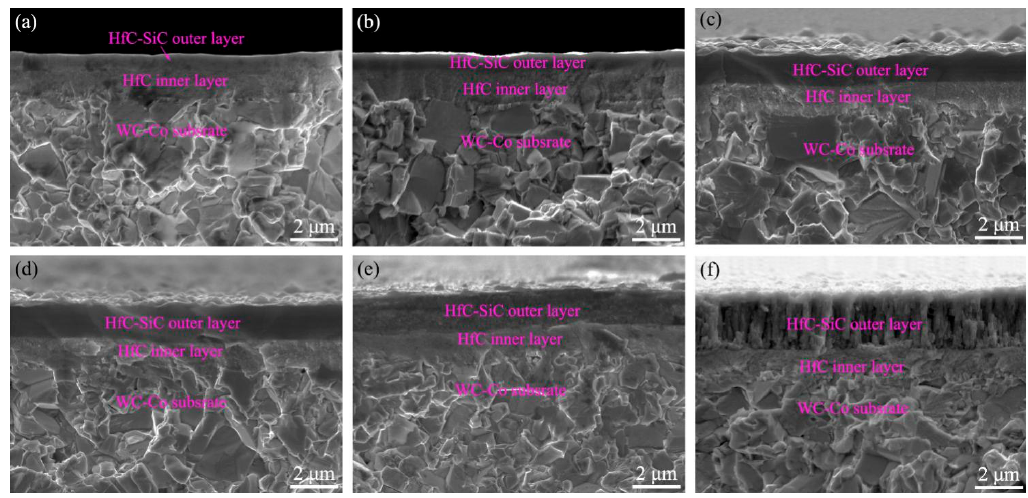
TMS flow rate increment: (a) 0.10 sccm/2 min, (b) 0.15 sccm/2 min, (c) 0.20 sccm/2 min, (d) 0.25 sccm/2 flow rate increment: ( a ) 0.10 sccm / 2 min, ( b ) 0.15 sccm / 2 min, ( c ) 0.20 sccm / 2 min, ( d ) 0.25 sccm / 2 min,